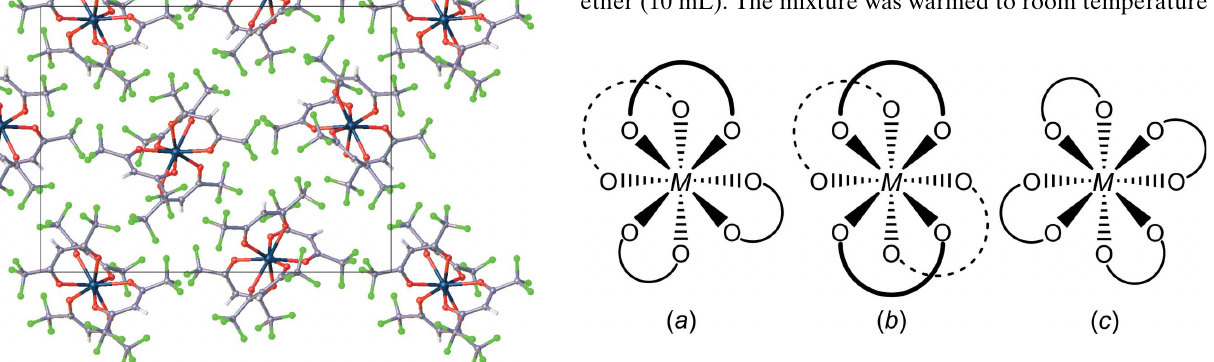
Figure 5 The three different isomers of square antiprismatic tetrakis(bidentate) metal complexes. Point symmetries: ( a ) 2, ( b ) 222, ( c )